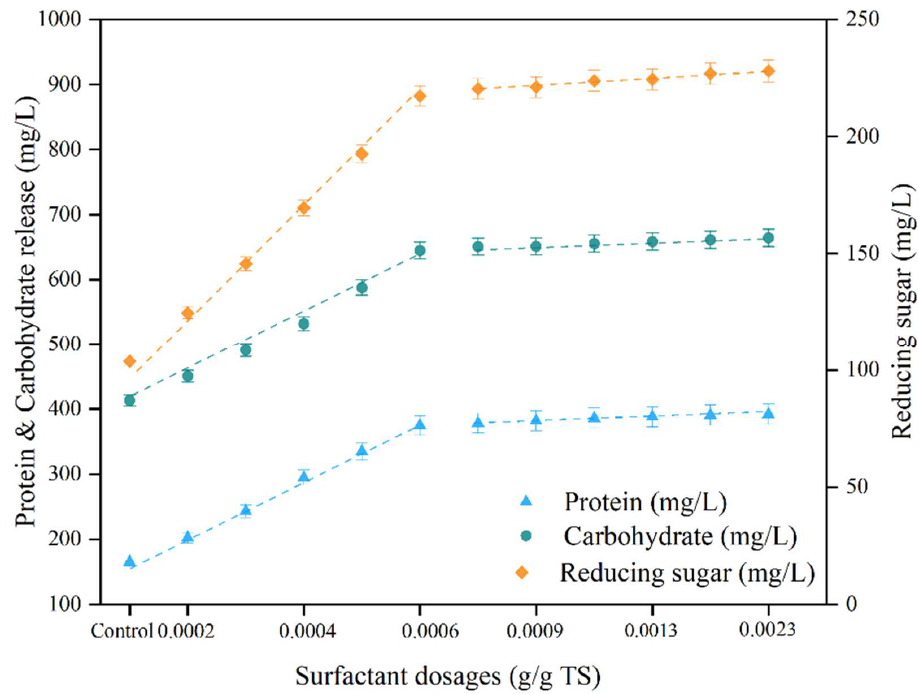
Figure 6. Effect of surfactant dosage on the release of protein, carbohydrates, and reducing sugars.